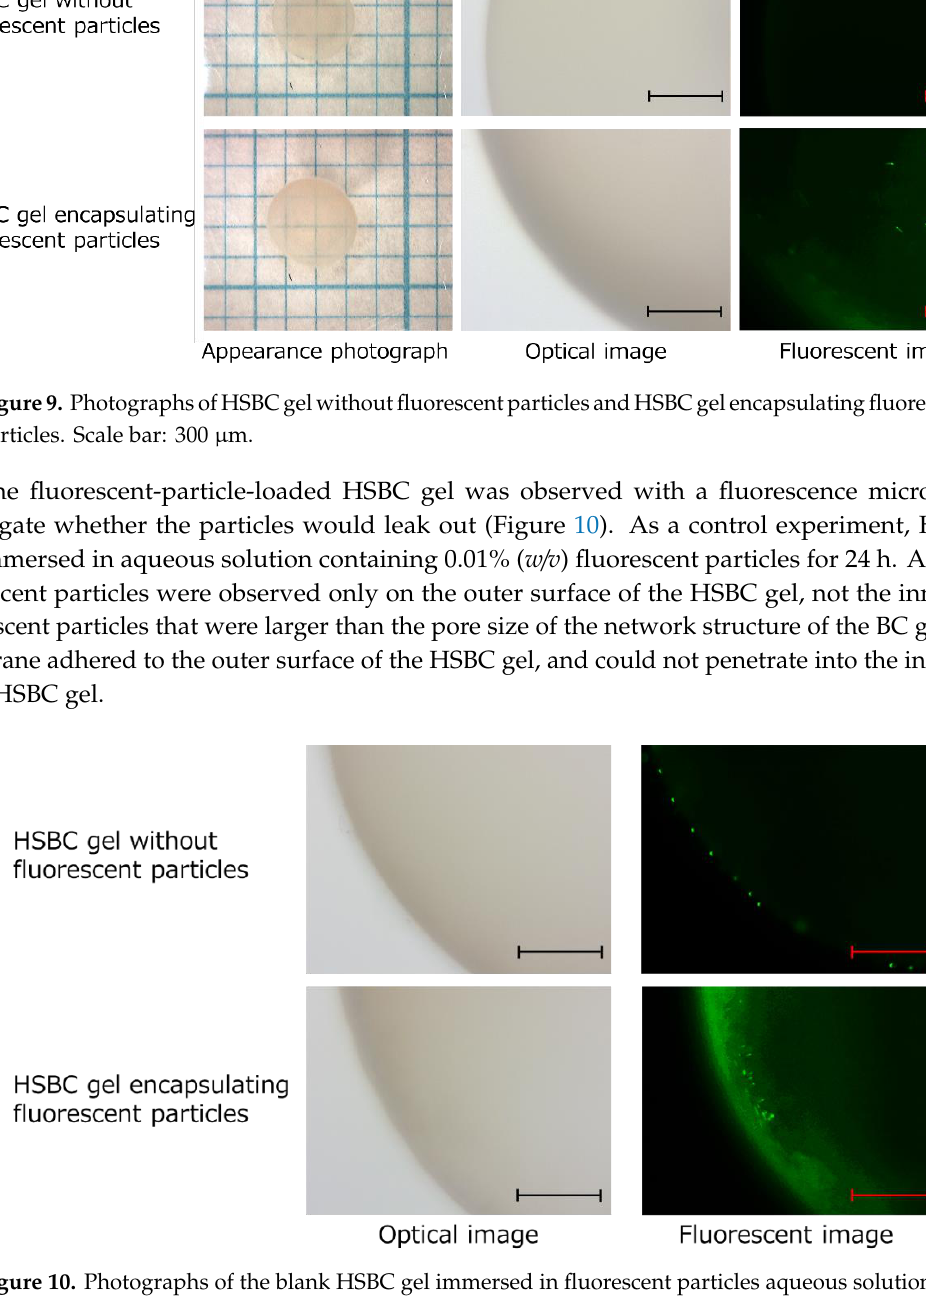
Figure 9. Photographs of HSBC gel without fluorescent particles and HSBC gel encapsulating fluorescent particles. Scale bar: 300 µm.